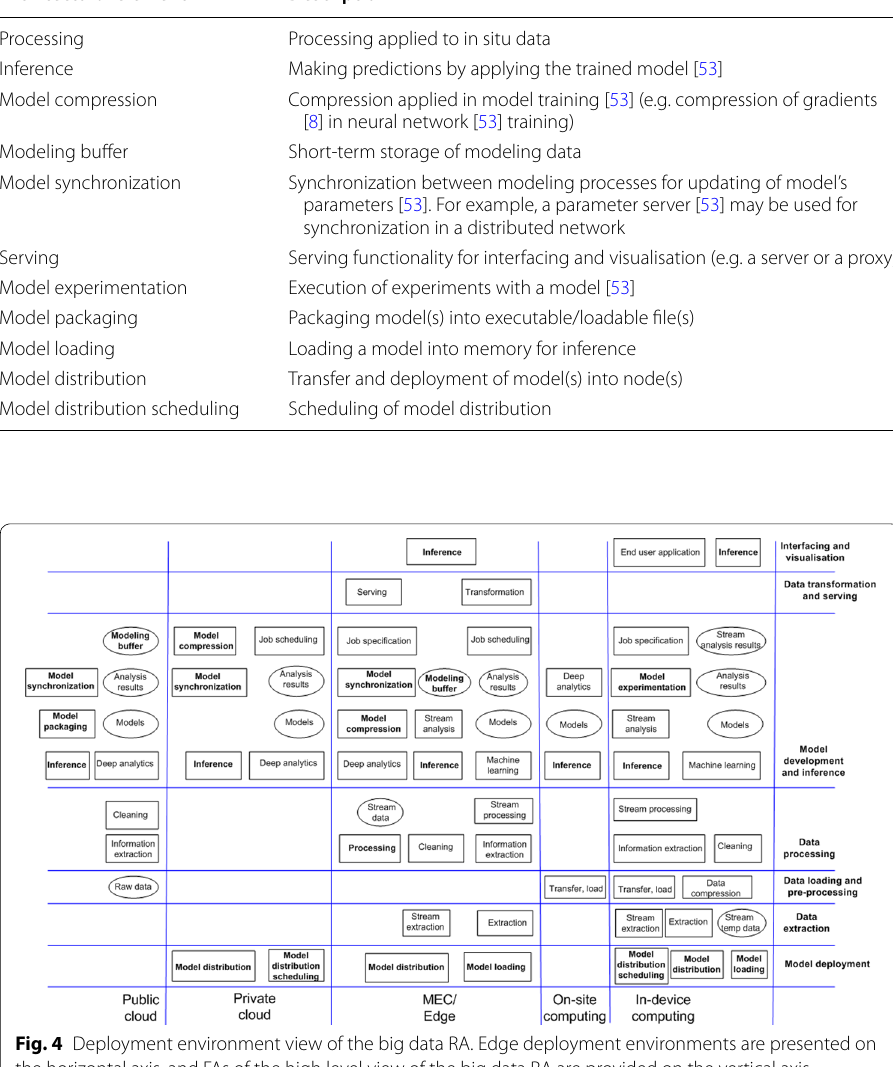
Table 1 Descriptions of new architectural elements of the RA Architectural element